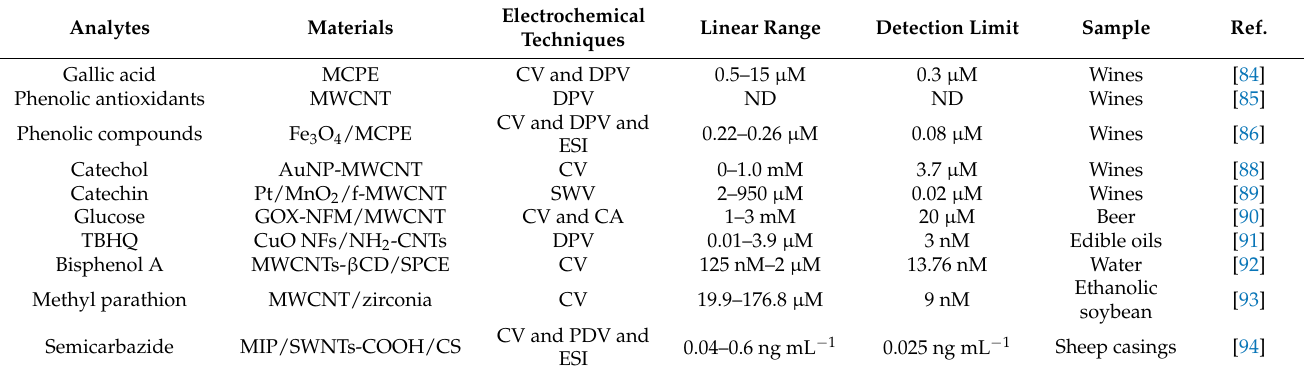
Table 2. Application of electrochemical sensors based on CNT-based materials associated with electrochemical techniques for the detection of different target analytes in foods and beverages. Electrochemical Linear Range Detection Limit Sample Analytes Materials Techniques